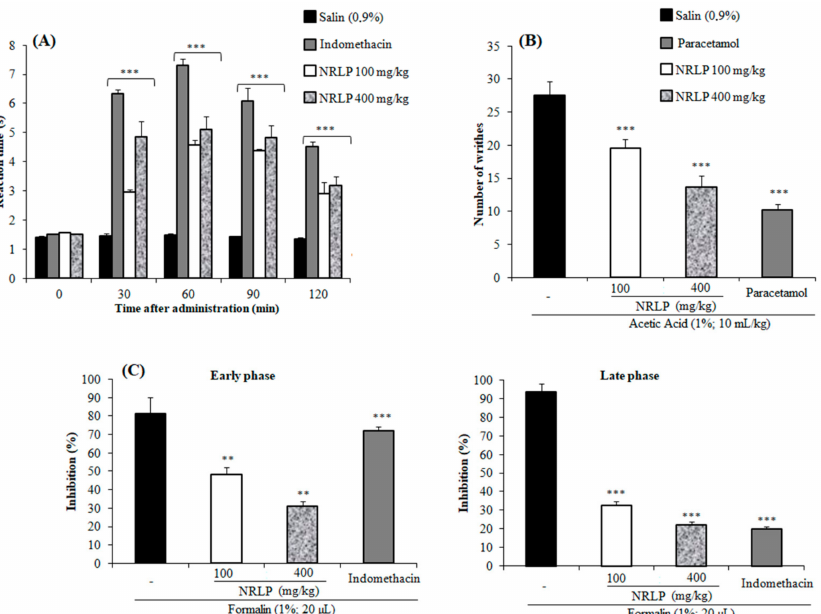
Figure 5. Antinociceptive activity of NRLP (100 and 400 mg / kg) and indomethacin (10 mg / kg) evaluated using ( A ) hot-plate, ( B ) acetic acid tests. ( C ) The formalin test was measured during the early phase (0–5 min) and late phase (15–30 min). All data are expressed as mean ± SD ( n = 6). *** p < 0.001 and ** p < 0.01 when compared with the normal control